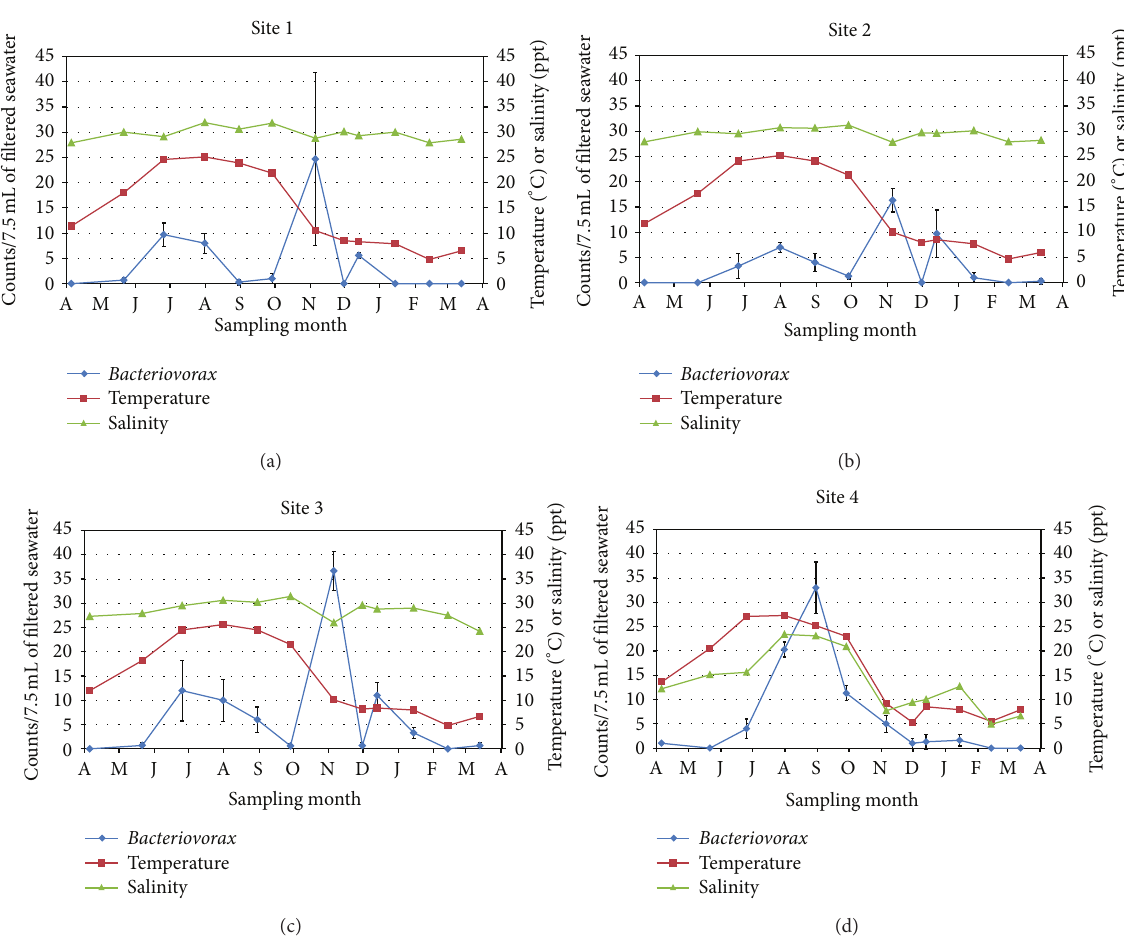
Figure 3: Overlay of Bacteriovorax level, temperature, and salinity for each of four sites along the Delaware Bay. ((a)–(d)) represent Sites 1–4, respectively. Bacteriovorax levels are the mean ± SD of three separate analyses for each